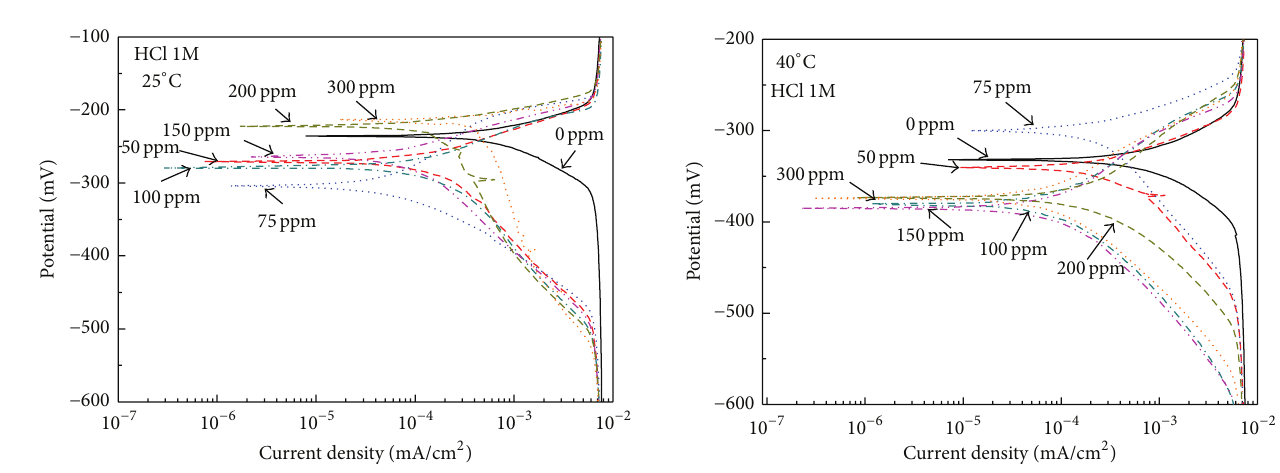
Figure 4: Effect of Opuntia ficus-indica concentration on the polar- ization curves for carbon steel in 1M HCl at 40 ∘ C.